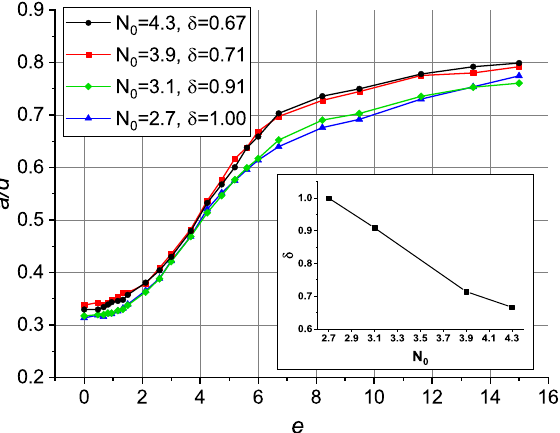
Figure 5. Calculated dependencies of relative dark zone size a / d on the dimensionless electric field e for droplets with various chiral parameter N 0 and arbitrary compression ratio δ . The inset shows δ ( N 0 )